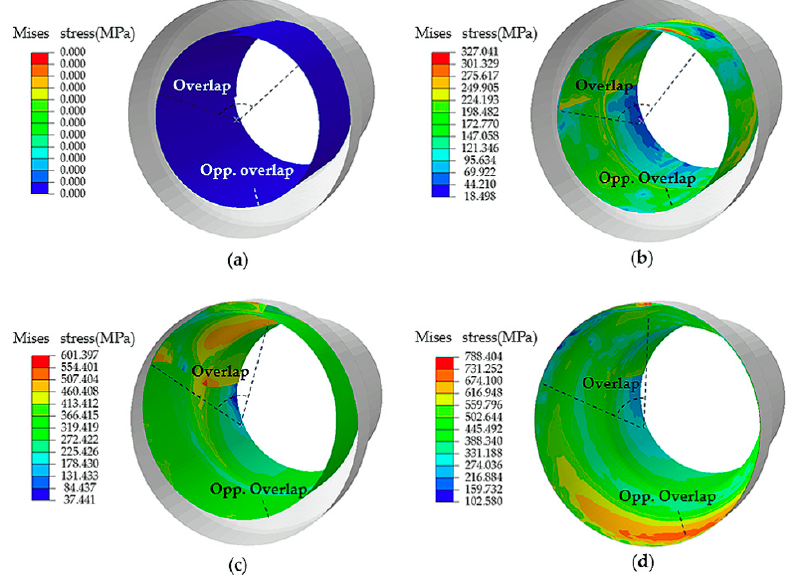
Figure 19. Deformation process of the overlapping tubular blank. ( a ) p = 0 (initial state); ( b ) p = 2.0 MPa; ( c ) p = 5.0 MPa; ( d ) p = 9.0 MPa.